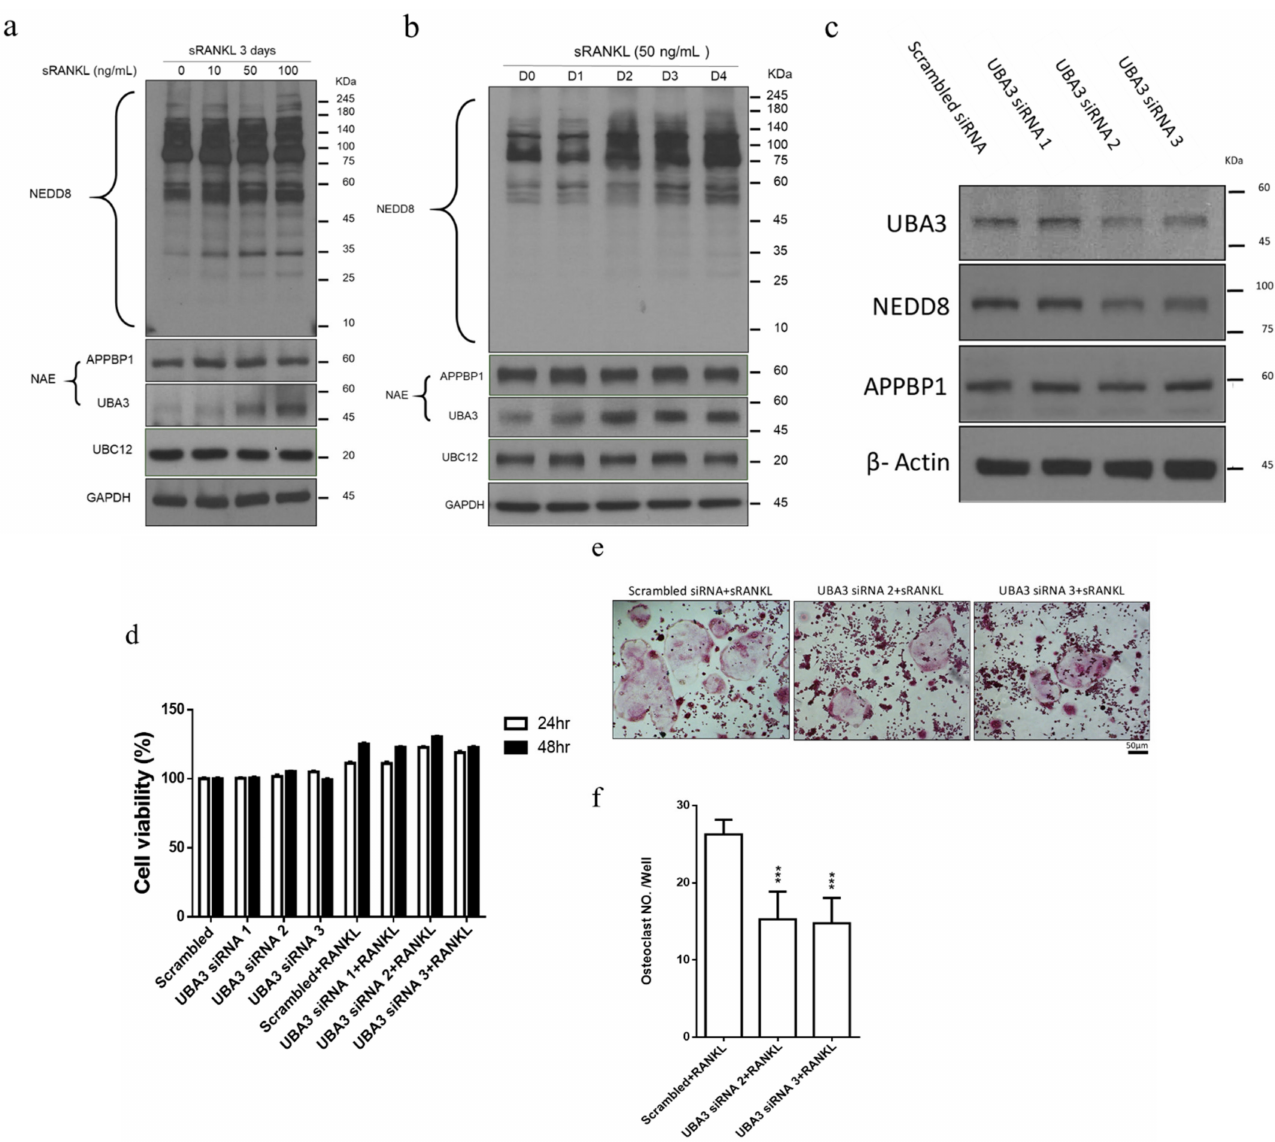
Figure 1. Effect of soluble receptor activator of nuclear factor- κ B ligand (sRANKL) on the neddyla- tion pathway and the effect of UBA3 siRNA on macrophages during osteoclast differentiation in